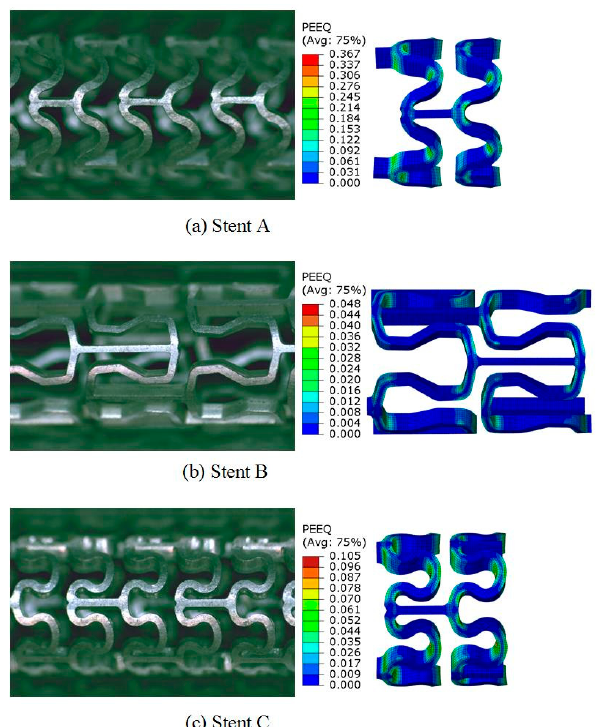
Figure 11. Experimental and simulated profiles of ( a ) Stent A, ( b ) Stent B, and ( c ) Stent C after crimping to an outside diameter of 2.5 mm. PEEQ: equivalent plastic strain.